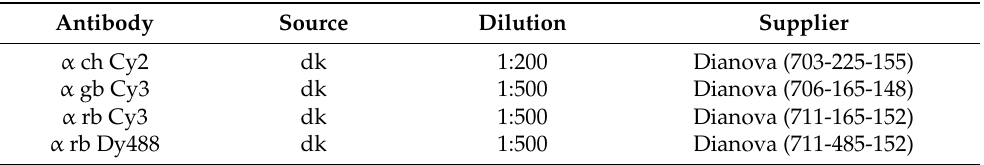
Table 2. Secondary antibodies used for immunocytochemistry. List of secondary antibodies applied for immunocytochemistry. Supplier: Dianova, Hamburg, Germany. Abbreviations: ch, chicken; dk, donkey; gp, guinea pig; rb,